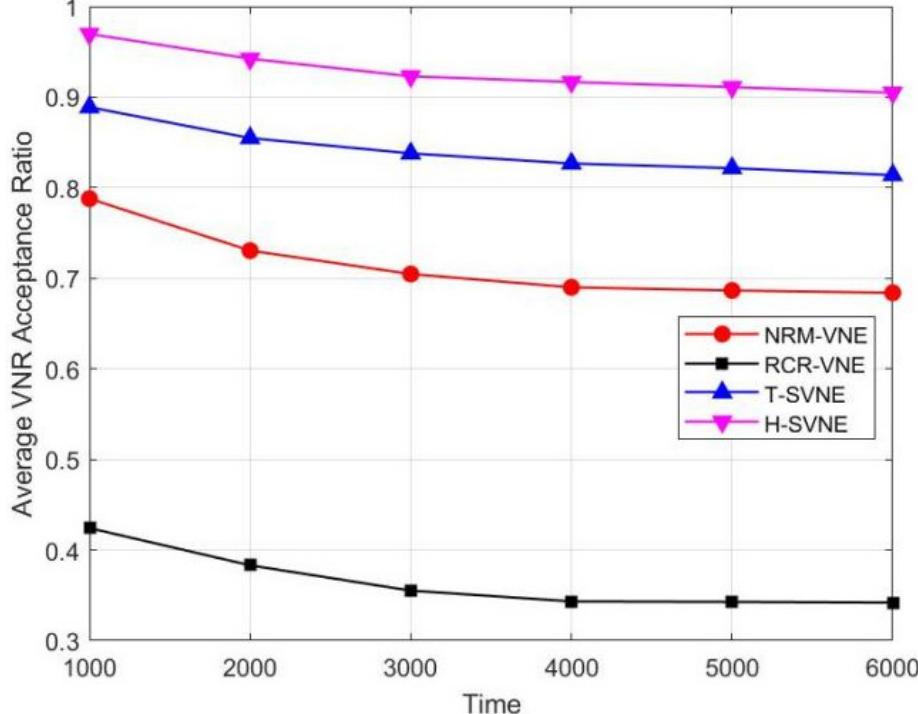
Figure 4. The average acceptance ratio.